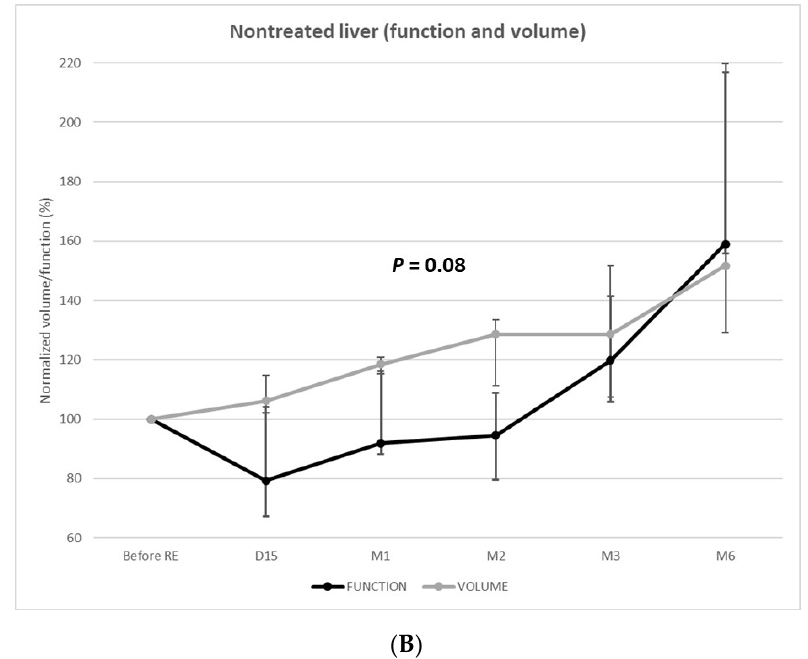
Figure 3. Function and volume changes from baseline of the treated ( A ) and nontreated ( B ) livers.